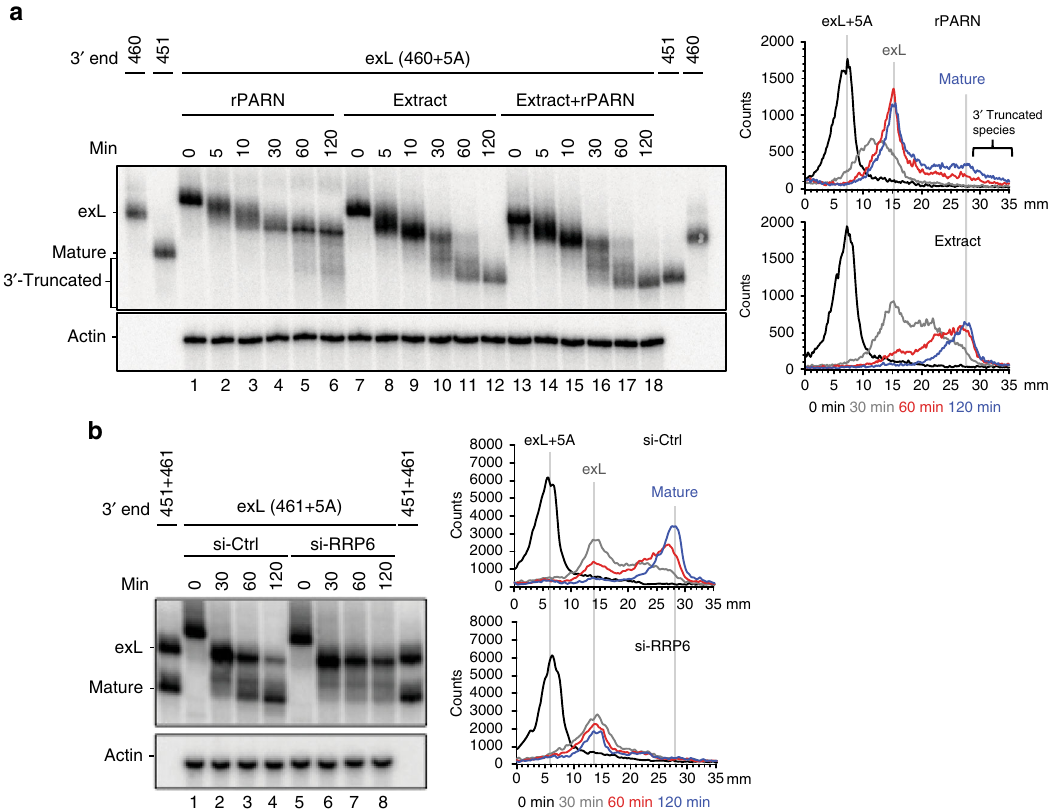
Fig. 3 The role of RRP6 in the processing of exL. a The 32 P-labeled in vitro transcribed hTR fragments (nucleotides 206 to 461 with oligo A tails) were incubated with 5.0 nM of recombinant PARN or in HeLa cell extracts (20 μ g) without or with 5.0 nM of recombinant PARN at 37 °C for the indicated times. RNA was puri fi ed and resolved on a 6% polyacrylamide/8 M urea gel. b The 32 P-labeled in vitro transcribed hTR fragments (nucleotides 206 to 461 with oligo A tails) were incubated in extracts prepared as indicated in Supplementary Figure 1b. The reaction was performed at 37 o C for the indicated